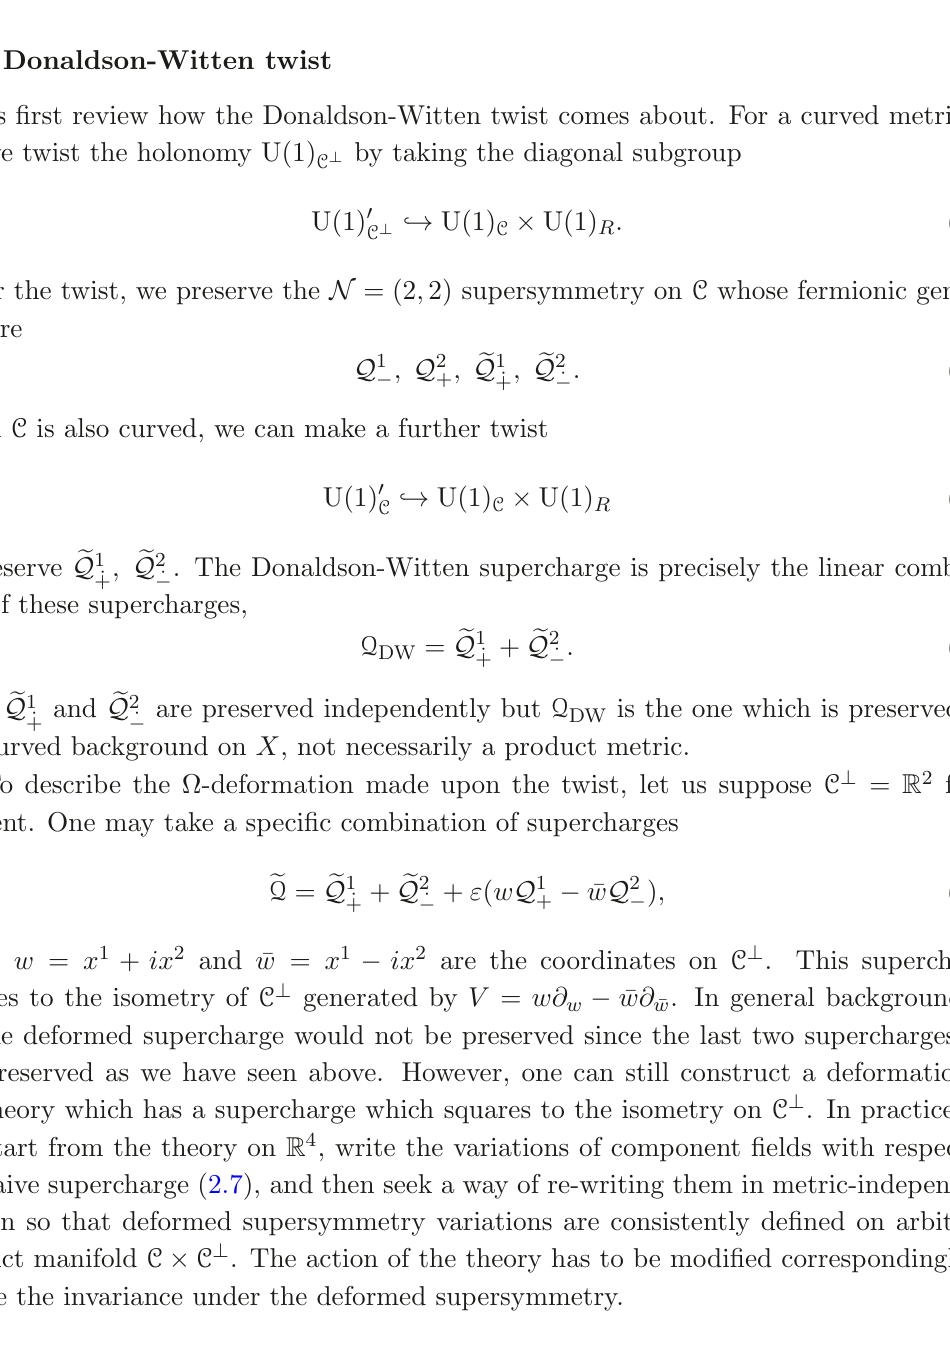
Table 1 . N = 2 supercharges and quantum